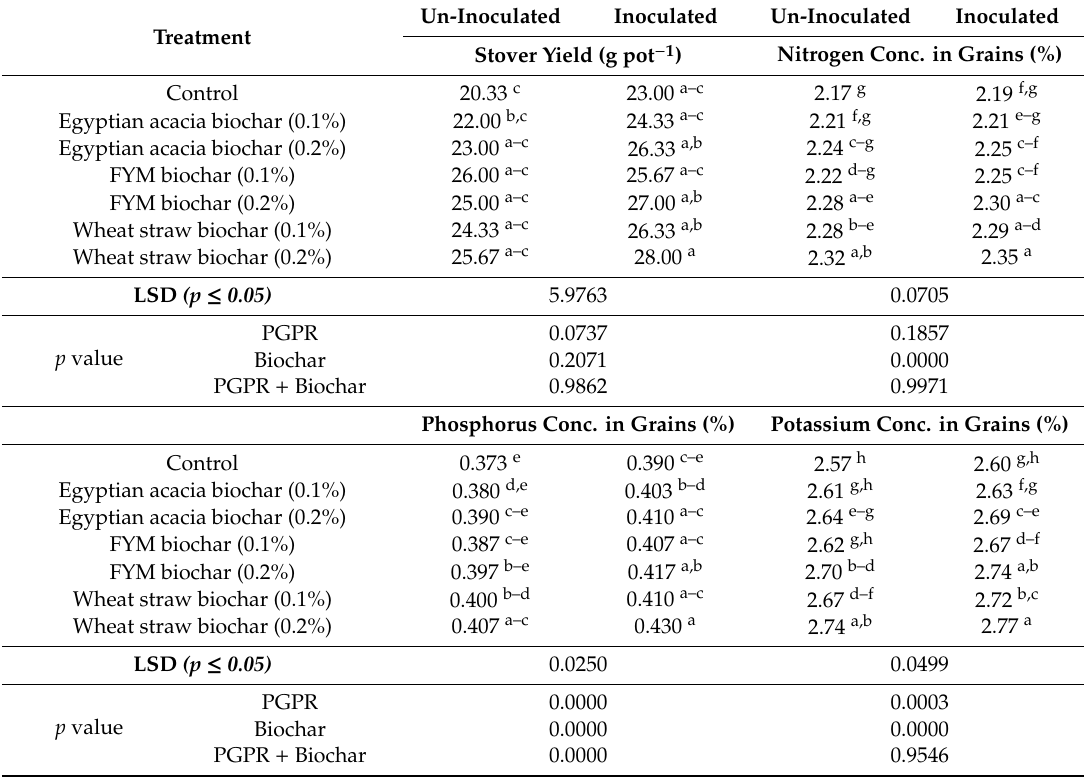
Table 4. E ff ects of biochar with and without Bacillus sp. ZM20 on stover yield, and nitrogen, phosphorus and potassium concentration in grains of maize in pot